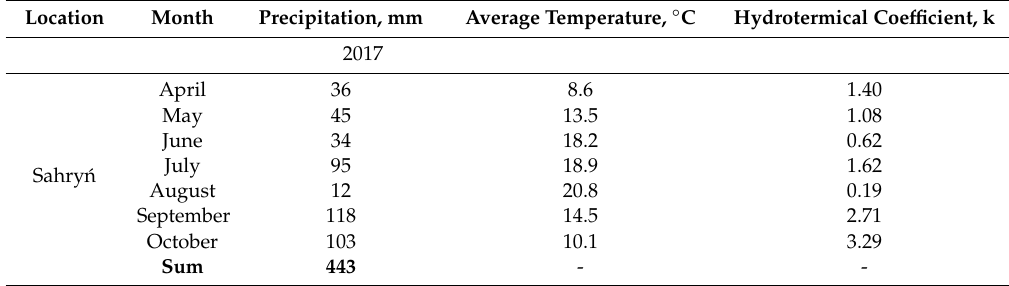
Table 2. Weather conditions during the growing season of sugar beet